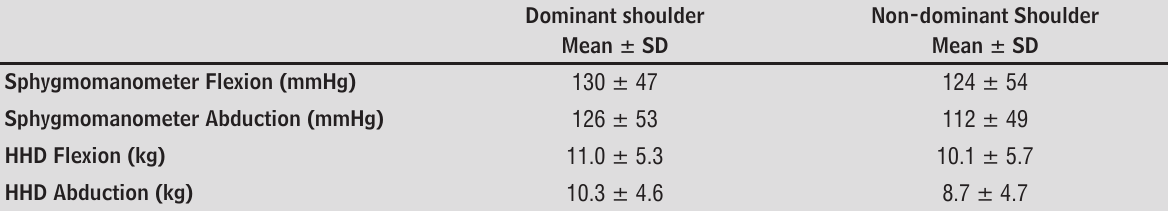
Table 3 - Mean measures of isometric shoulder strength in both